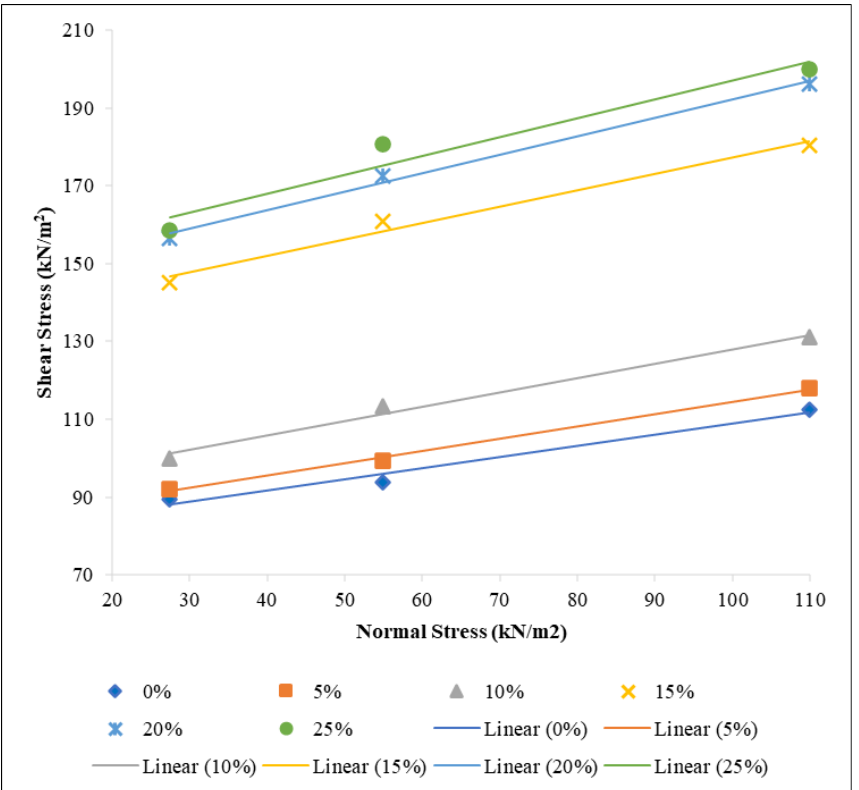
Figure 10. Direct shear failure envelope of the clay – CHA mixture.